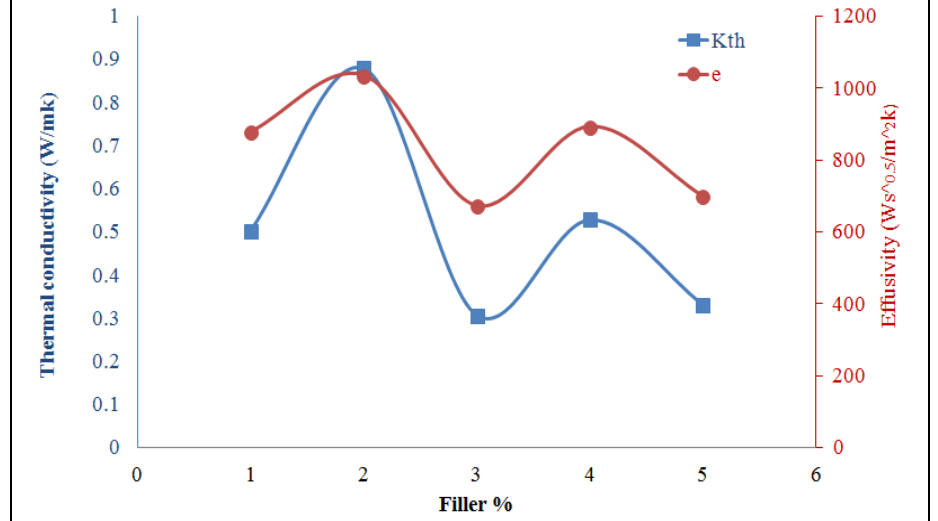
Fig.17: Thermal conductivity for UP/ nano SiO